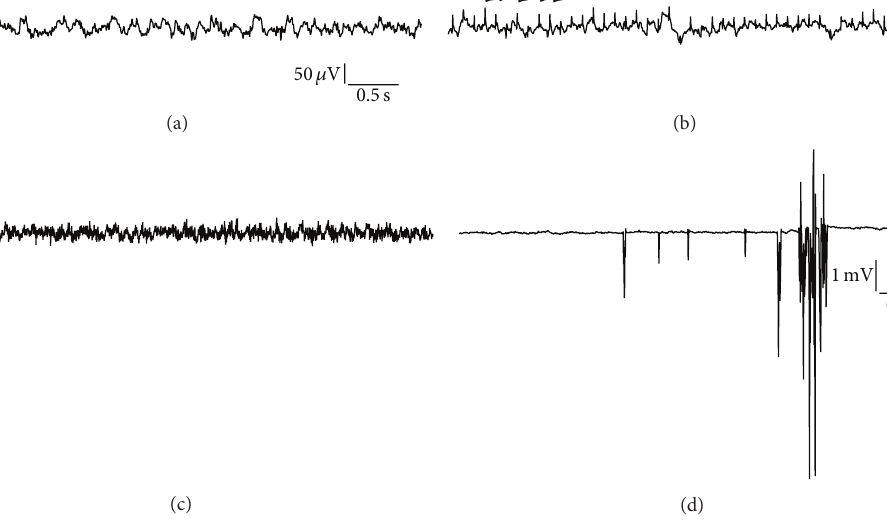
Figure 8: Electrocardiographic/electromyographic and system artefacts contaminating the EEG (deep electrodes (a)–(c), surface electrodes (d), vertical bar: 50 𝜇 V in (a)–(c), and 1mV in (d)). (a) Intrahippocampal EEG recording from a control mouse. (b) Damaged silicone insulation of the sensing leads as well as ossification processes originating from the edge of drilled holes can result in dramatic contamination of electroencephalographic recordings. Note the regular pattern of interfering ECG signal, that is, R-spikes (arrows). Importantly, ECG contamination cannot be completely avoided but the implantation procedure presented here will reduce it to a minimum. (c) Electromyographic contamination of the EEG characterized by high frequency activity. (d) Artefacts can also originate from cross-talk between receiver plates or from electrical noise evolving from room lights or various other electrical devices that are close to the receiver plates. An effective way of preventing the system picking up noise is to shield receiver plate and home cage using a ventilated cabinet or a Faraday cage (with permission from